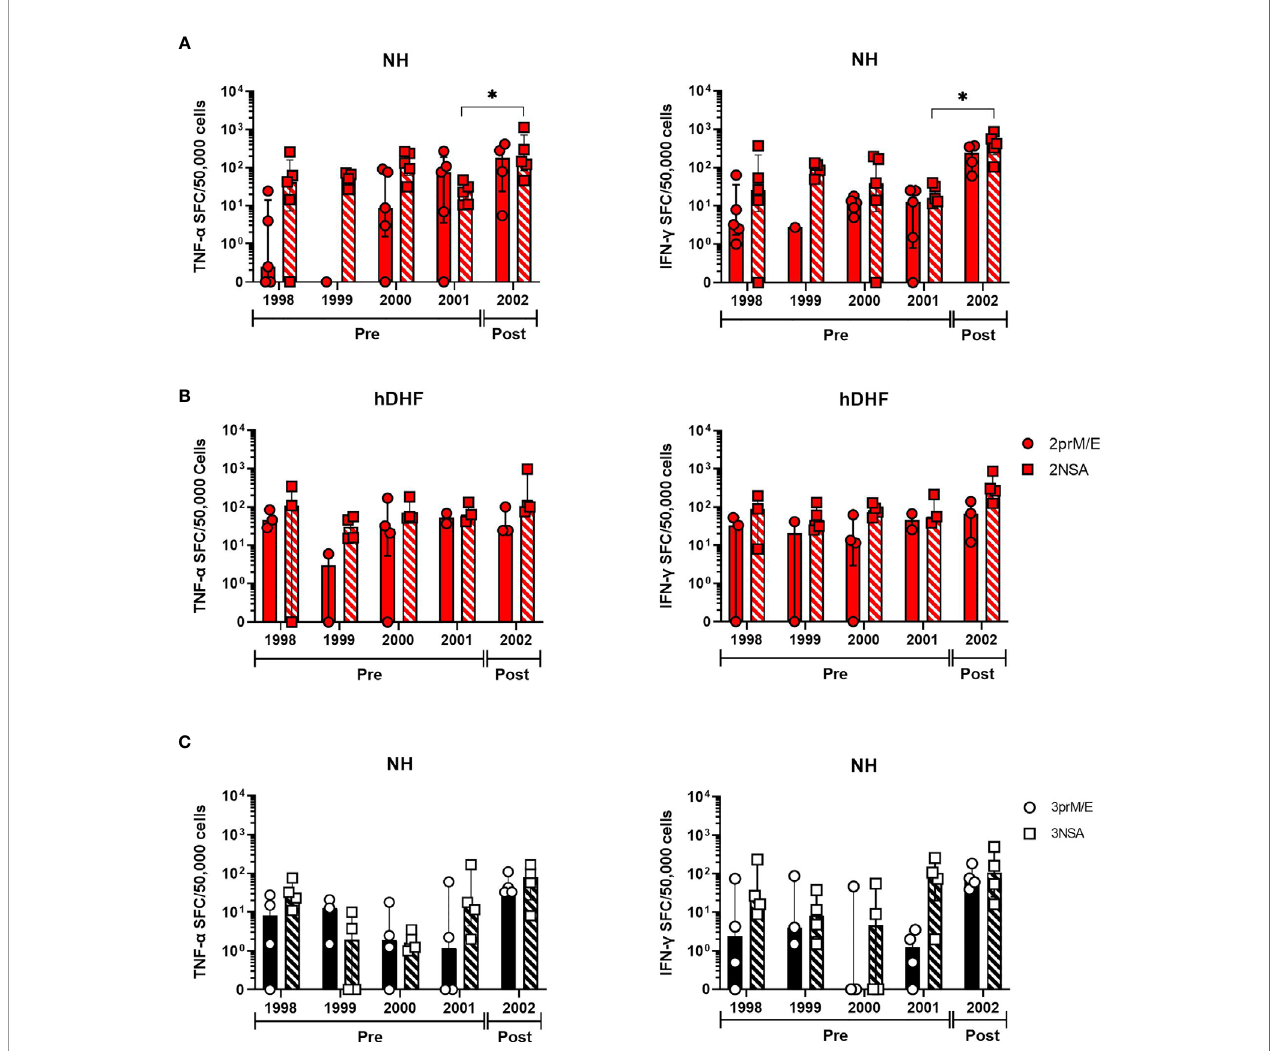
FIGURE 2 | Trends in DENV-speci fi c cytokine-producing T cell frequencies over the 5-year study period. Longitudinal analysis of cultured TNF- a (left panels) and IFN- g (right panels) spot-forming cell (SFC) frequencies in PBMC collected before (pre) or after (post) secondary DENV infections in subjects with (A) DENV-2, non- hospitalized (NH) (B) DENV-2, hospitalized DHF (hDHF), and (C) DENV3 NH. Symbols represent the frequency of cytokine-producing cells in PBMC from each subject detected by cultured ELISPOT. PBMC were stimulated with peptide pools corresponding to prM and E proteins (prM/E) or NS1, NS3, and NS5 proteins (NSA) of the indicated DENV serotype. Bars represent median + interquartile range. Statistics were calculated by the nonparametric Kruskal-Wallis with Dunn ’ s multiple comparison post-tests. *p <